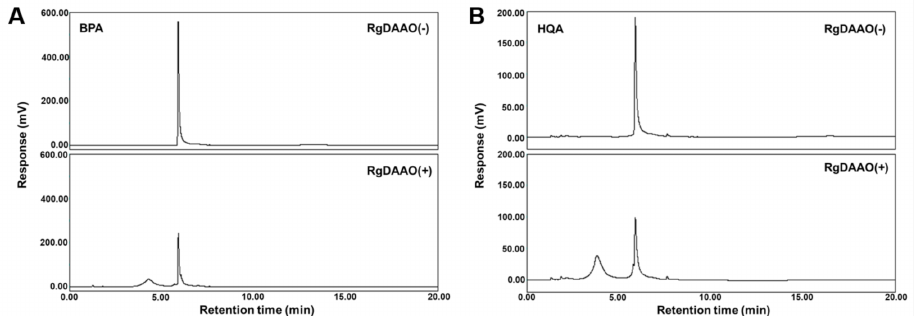
Figure 3. HPLC (C18) analyses of RgDAAO reactions for racemic BPA ( A ) and HQA ( B ). Conditions: 50 mM HEPES-NaOH (pH 8.0), 0.1 M KCl, 1.0 mg/mL catalase, 5 mM UAA, and 5 µ M RgDAAO.